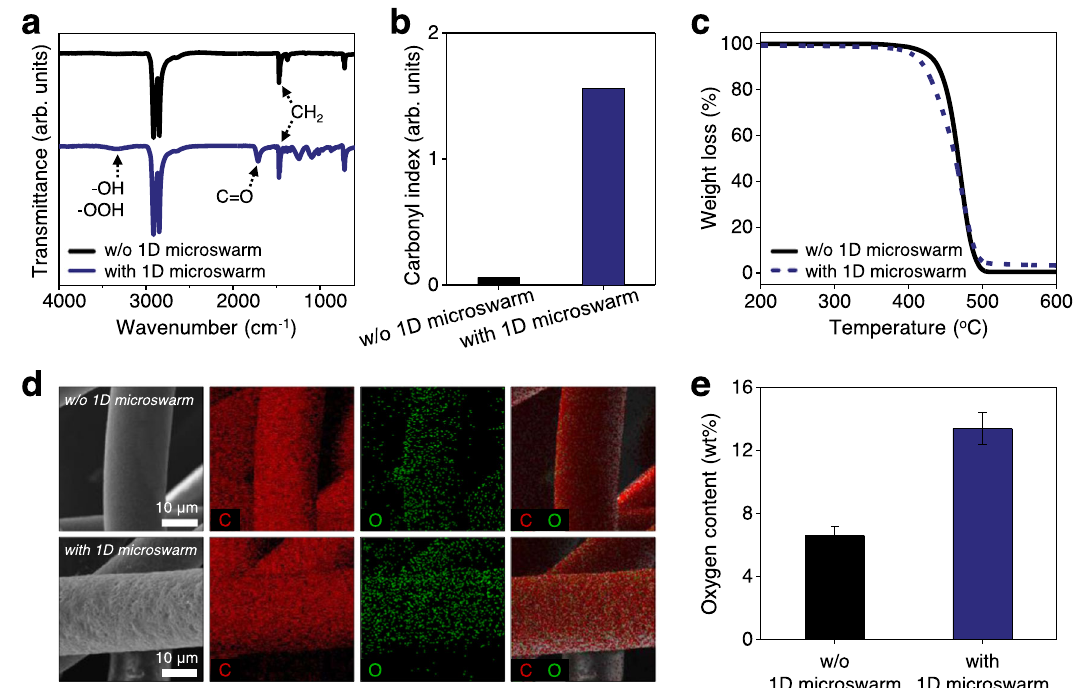
Fig. 7 | Compositional and structural characterization of the polypropylene fi lter membranes after photoactivation with and without 1D microswarm. a FTIR-ATRspectra, b carbonylindex,and c TGAcurvesofthePP fi ltermembranes after photoactivation with and without treatment of the 1D microswarm boosting.